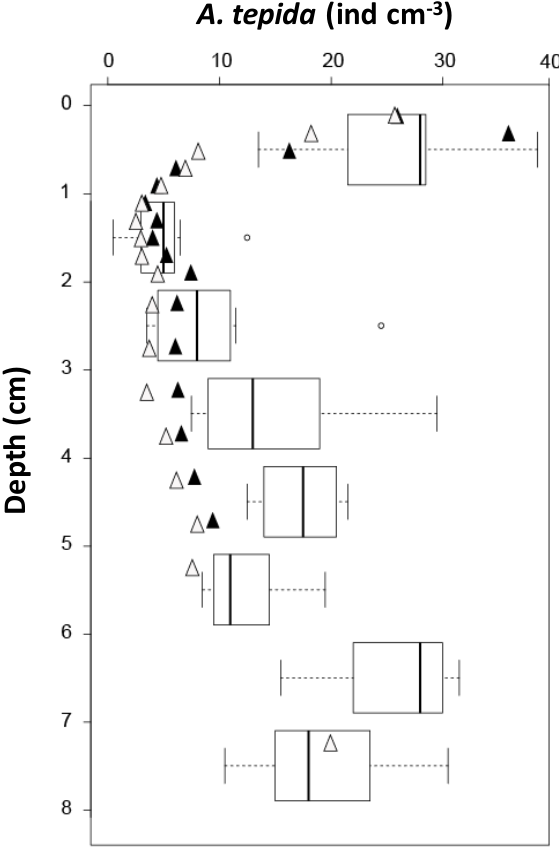
Figure 6. Vertical comparison of A. tepida densities from the two cores (filled and open triangles) and the “jaw device” sampling (each box plot represents the distribution of one layer; bars are first and third quartiles for the boxes length and whiskers are below 1.5 interquartiles; open circles are